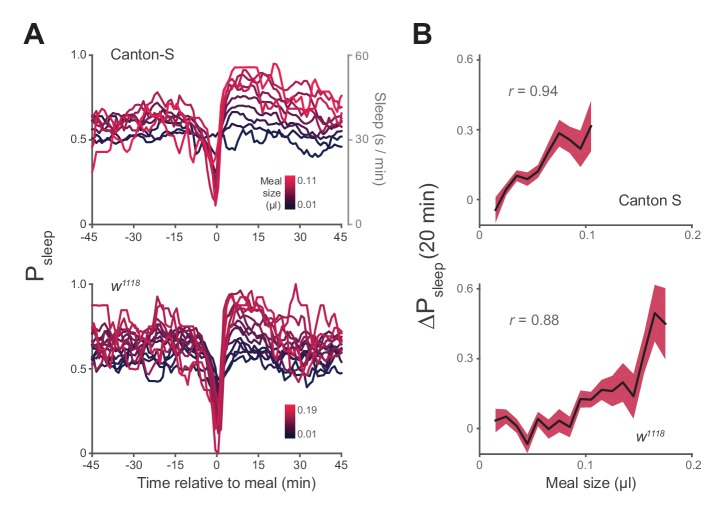
Postprandial sleep correlates with food intake quantity.(A) Sleep probability of Canton-S and w1118 surrounding meals of varying size (lines represent mean; color grading corresponds to meal size). Only groupings with n > 7 are shown for visualization. (B) 20 min ΔPsleep as a function of meal size for each grouping (Pearson correlation: p<0.001 for Canton-S and w1118.) Shaded lines represent mean ± s.e.m.